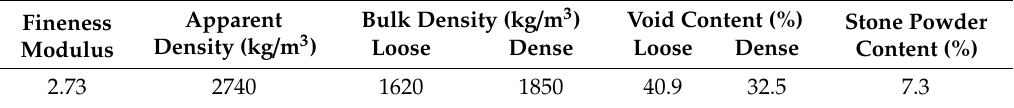
Table 3. Physical properties of manufactured sand.